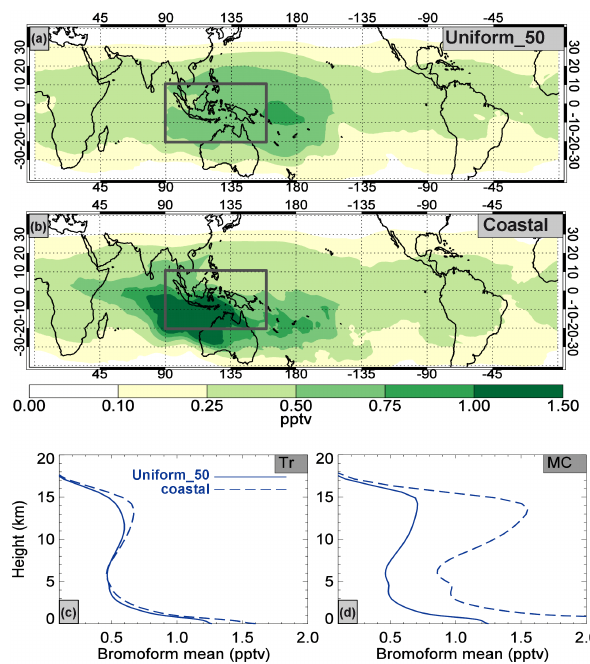
Figure 3. The monthly average mixing ratios at 15.7km in Febru- ary 2005 are shown for (a) the Uniform_50 tracer; and (b) the Coastal tracer. Average vertical profiles of the mixing ratios for the two tracers are shown for (c) the Tropics (20 ◦ S–20 ◦ N) and (d) the Maritime Continent (20 ◦ S–10 ◦ N; 90–160 ◦ E, as shown in (a) and (b)